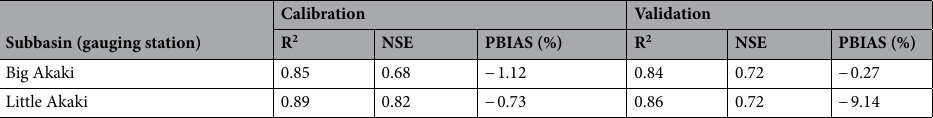
Table 4. SWAT-MODFLOW model calibration and validation performance indicating statistical values.